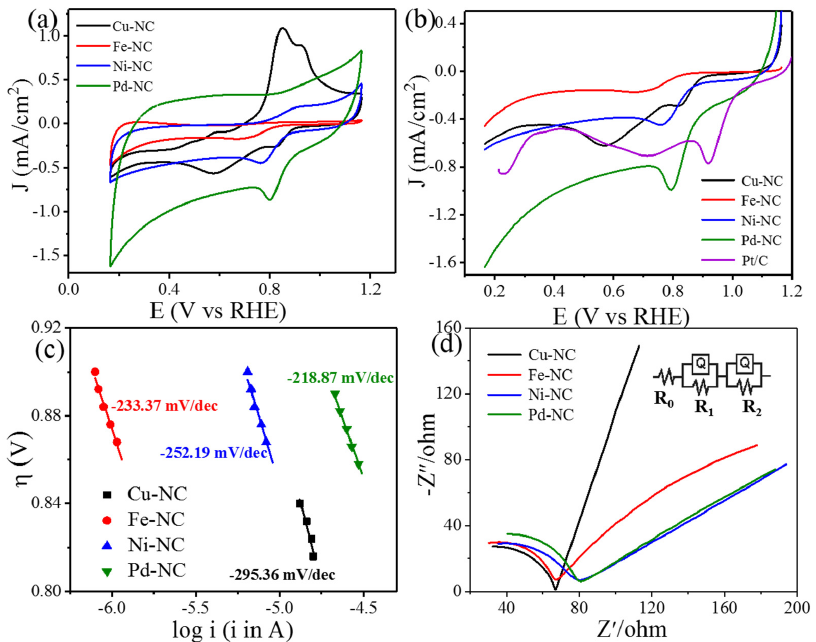
Figure 4. ( a ) CV tests in the oxygen-saturated 0.1 M KOH. LSV ( b ), Tafel ( c ) and EIS ( d ) tests of Pd-NC, Fe-NC, Cu-NC, and Ni-NC in the same electrolyte. As a comparison, the LSV test of Pt/C catalyst is also displayed